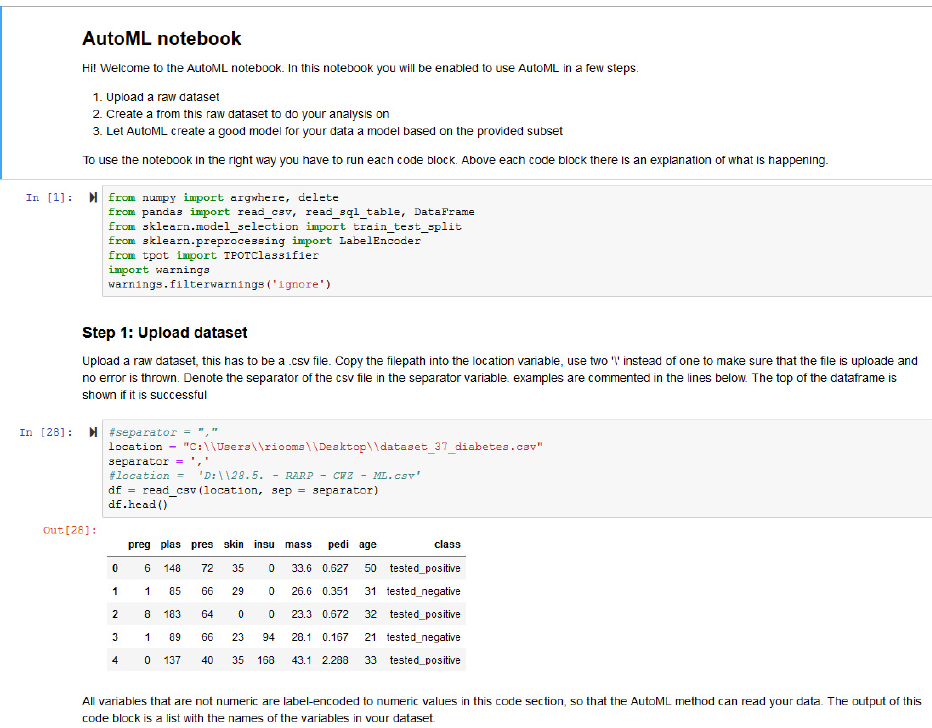
Figure C3. Screenshot of AutoML artefact B, the Jupyter notebook interface (preference: Code).